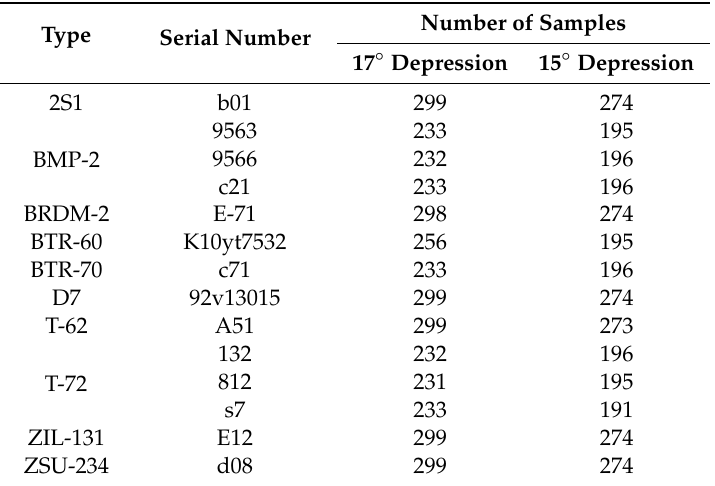
Figure 9. Photographs (the first row) and SAR imagery examples (the second row) of the moving and stationary target acquisition and recognition (MSTAR) dataset for model evaluation. From left to right, the types of vehicles are 2S1, BMP-2, BRDM-2, BTR-60, BTR-70, D7, T-62, T-72, ZIL-131, and ZSU-234. Table 2. Detailed information of the MSTAR